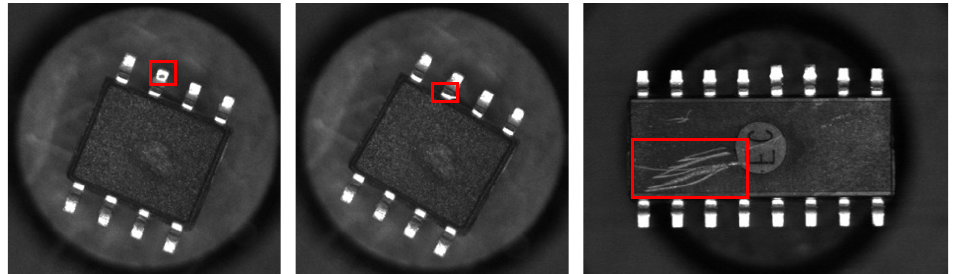
Figure 1. Appearance defects on an electronic